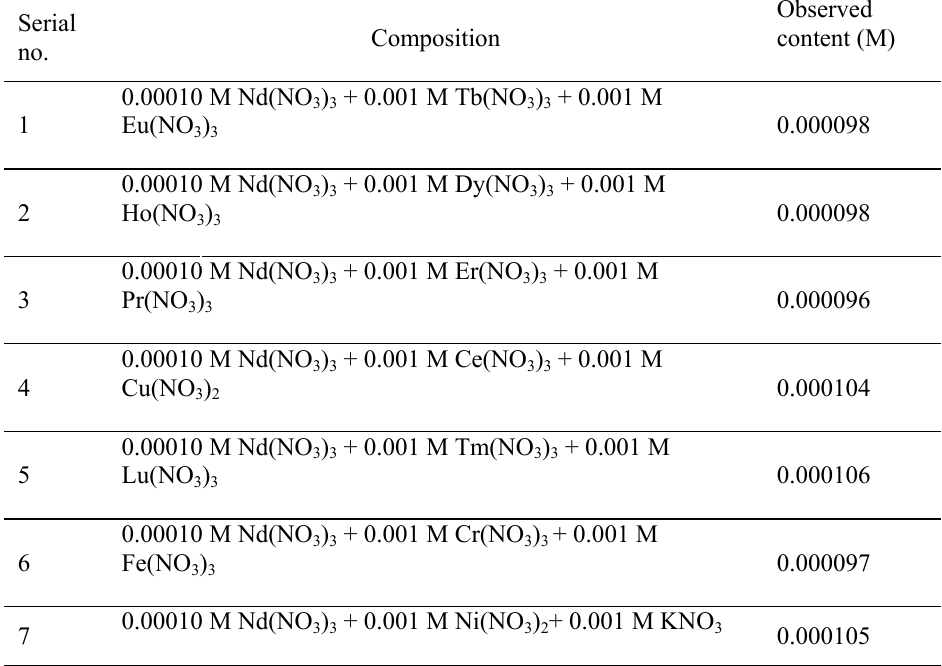
Table 4. Determination of Nd 3+ ions in mixtures of different ions.